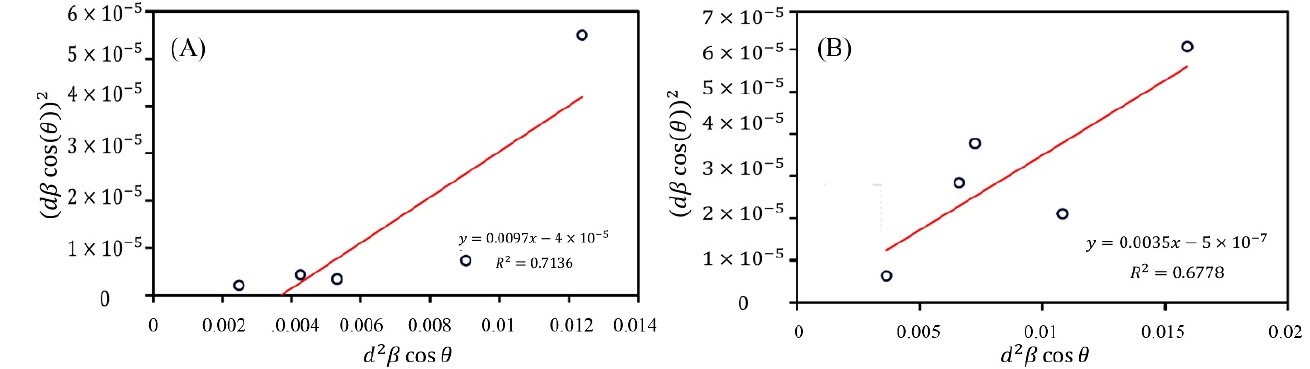
Figure 6. SSP plot for the Ag diffraction peaks in Zn 1 − x Ag x O. ( A ) x = 0.06 and ( B ) x = 0.09. Table 2. Ag concentration-dependent elastic constants and the NPs’ sizes. Scherrer Size Strain Compound